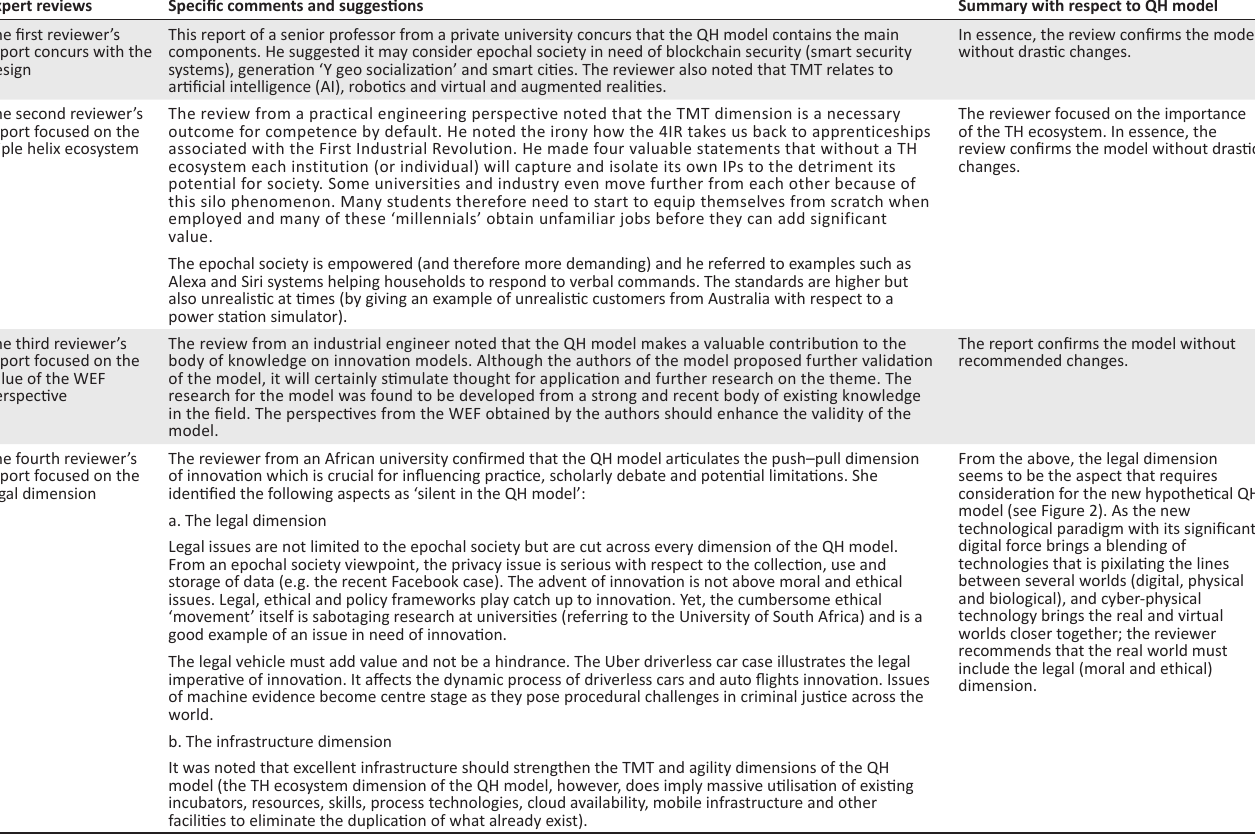
TABLE 2: Expert reviews of the quadruple helix model and